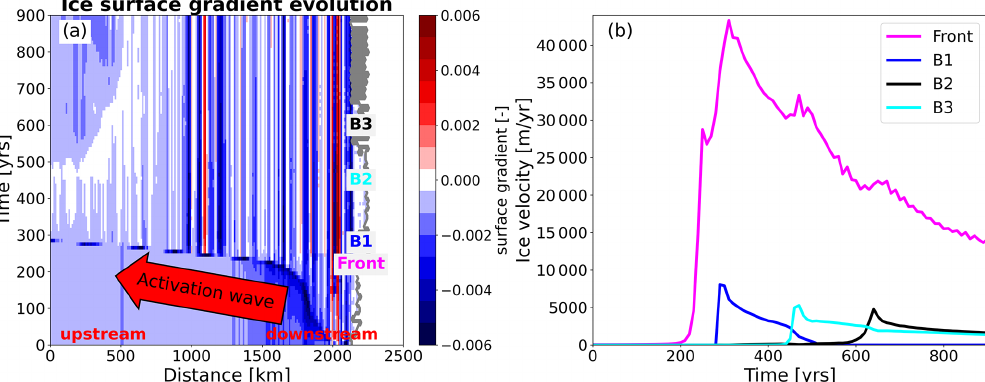
Figure 5. (a) Hovmöller diagram of Hudson ice stream along the flowline (Fig. 1) during a surge event. The surface gradient captures the rapid upstream expansion of the surge activation front. the grey line shows the marine margin. Panel (b) shows activation of different surge branches of Hudson ice stream for the same surge event. Points for velocity sampling in (b) were manually selected. Labels in (a) refer to the timing of surge activation of different branches (B1, B2, and B3) shown in (b)